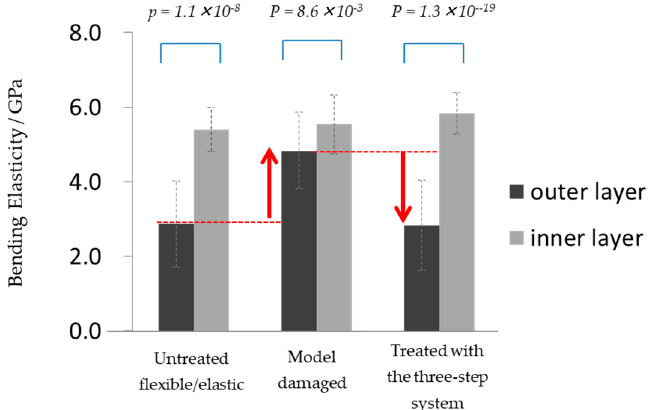
Figure 10. Bending elasticity of the outer and inner layer of Caucasian hair. Measurements at 20°C and 65% relative humidity (RH), n = 20; SS = sensory score.